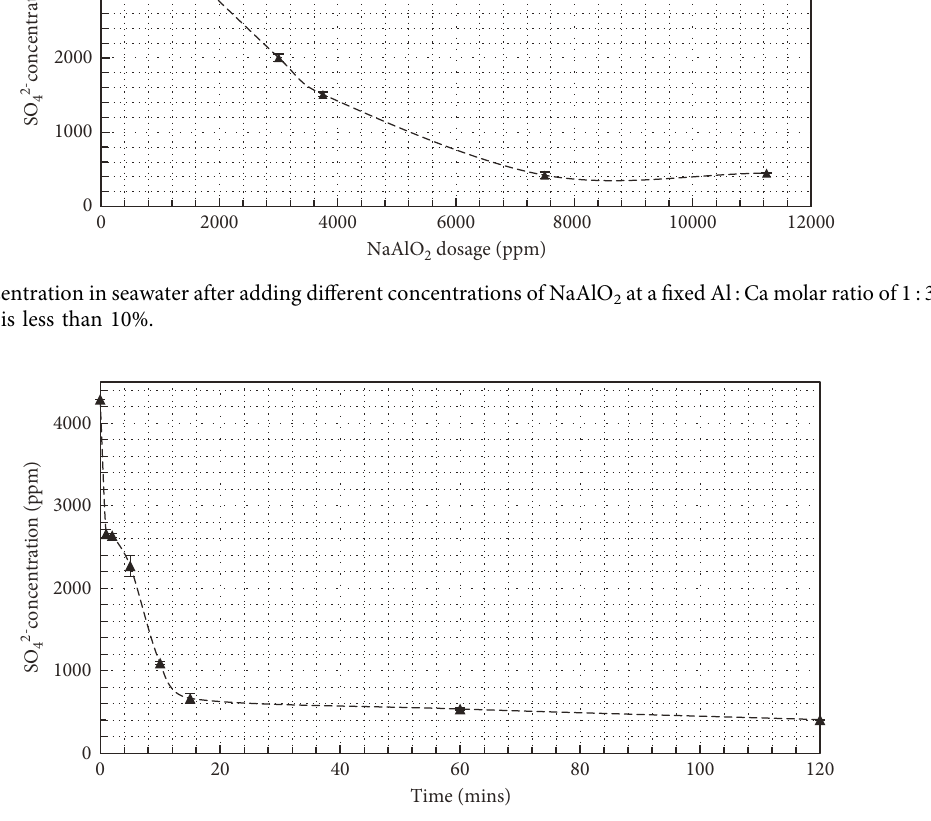
Figure 3: Effect of stirring time in precipitation reactions on the sulfate concentration in treated seawater using the ettringite method. The added molar ratio of Al :Ca:S is 2 :6:1. The RSD of sulfate concentration is less than